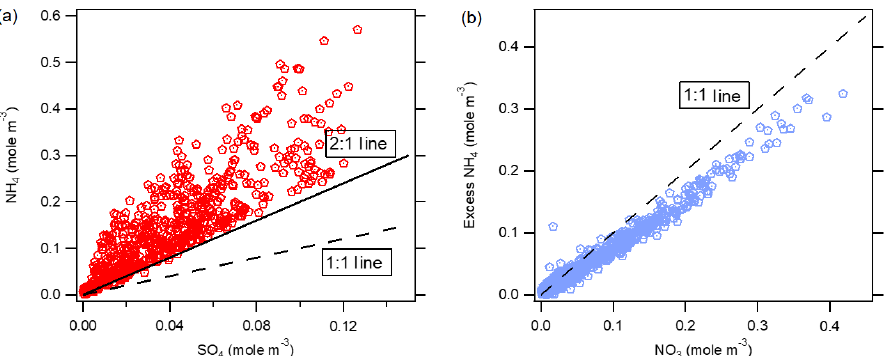
Figure 5. Comparison of the molar concentrations of (a) ammonium and sulfate (the 2:1 reference line represents complete H 2 SO 4 neutral- ization) and (b) excess ammonium and nitrate (the 1:1 reference line represents complete HNO 3 neutralization).